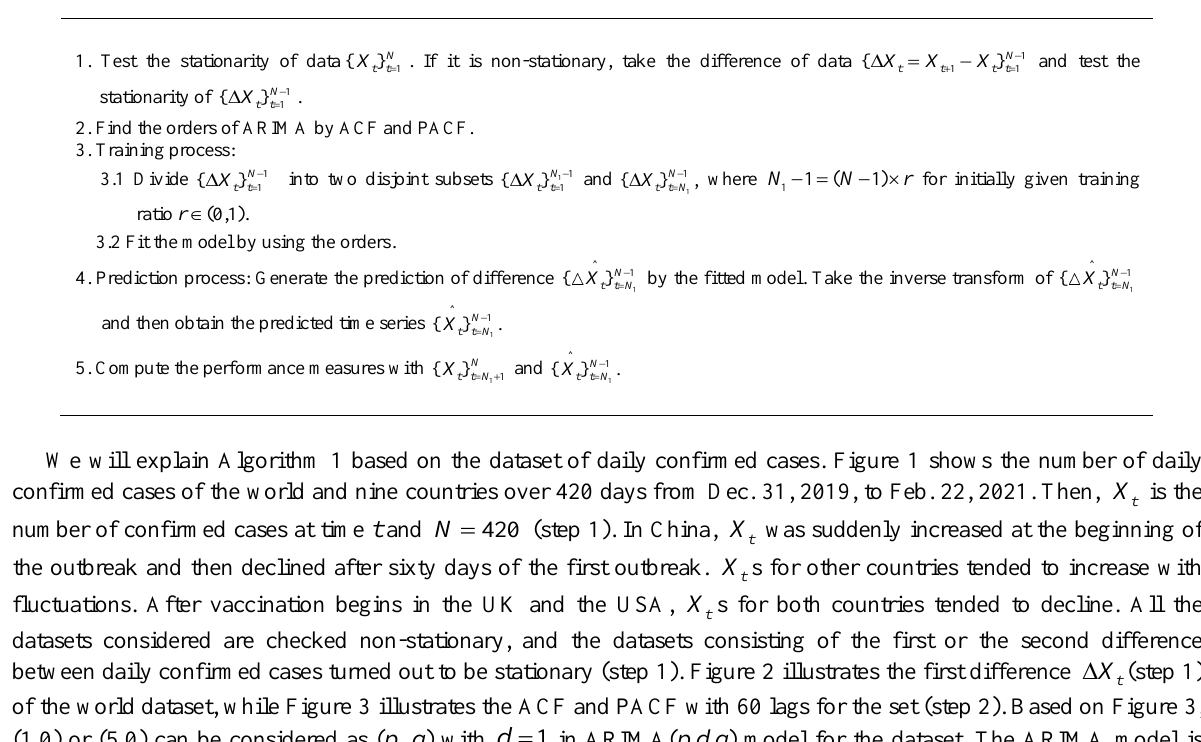
Algorithm 1. Prediction procedure of ARIMA